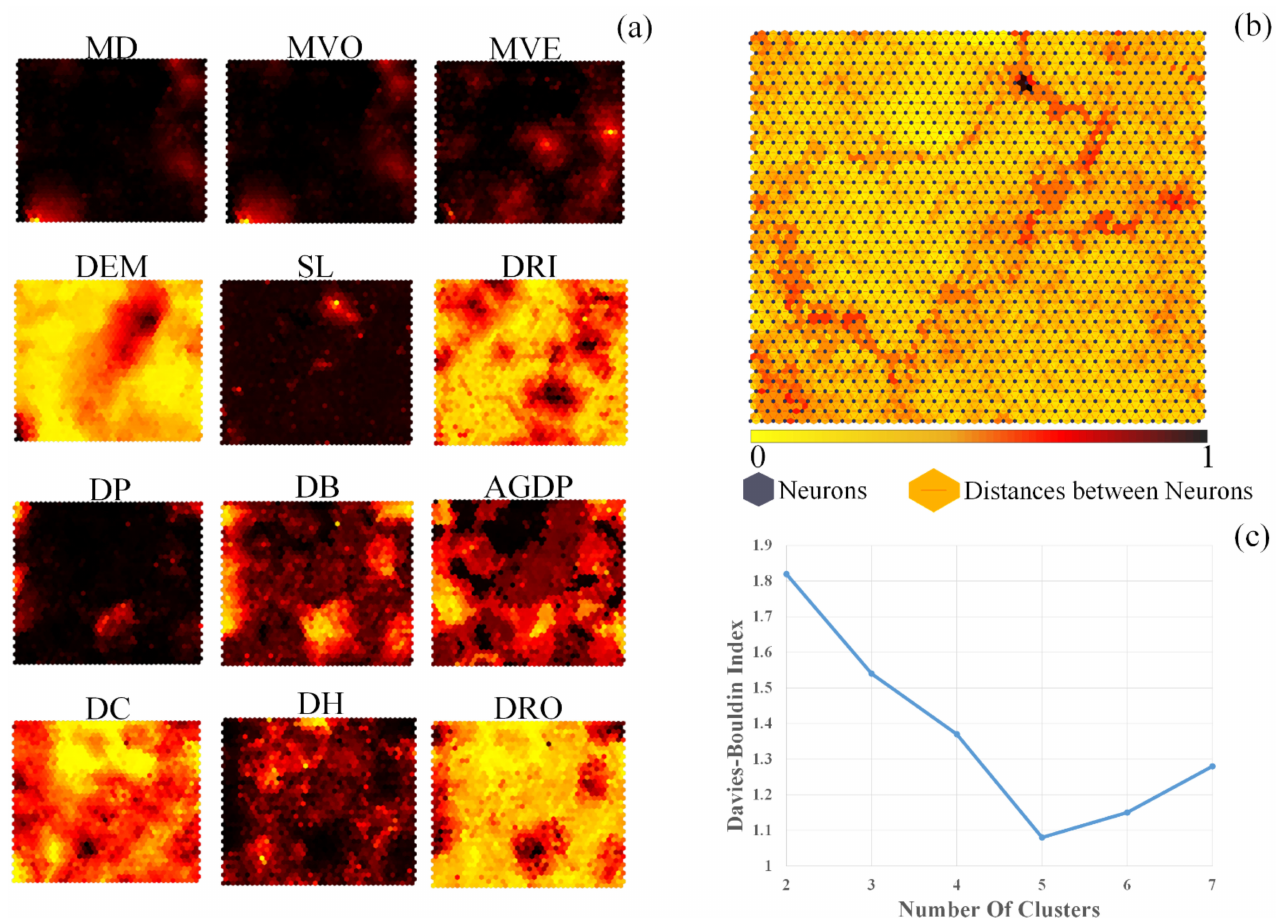
Figure 8. ( a ) The input planes; ( b )the weight distance matrix; and ( c ) the DBI values corresponding to different clustering numbers.